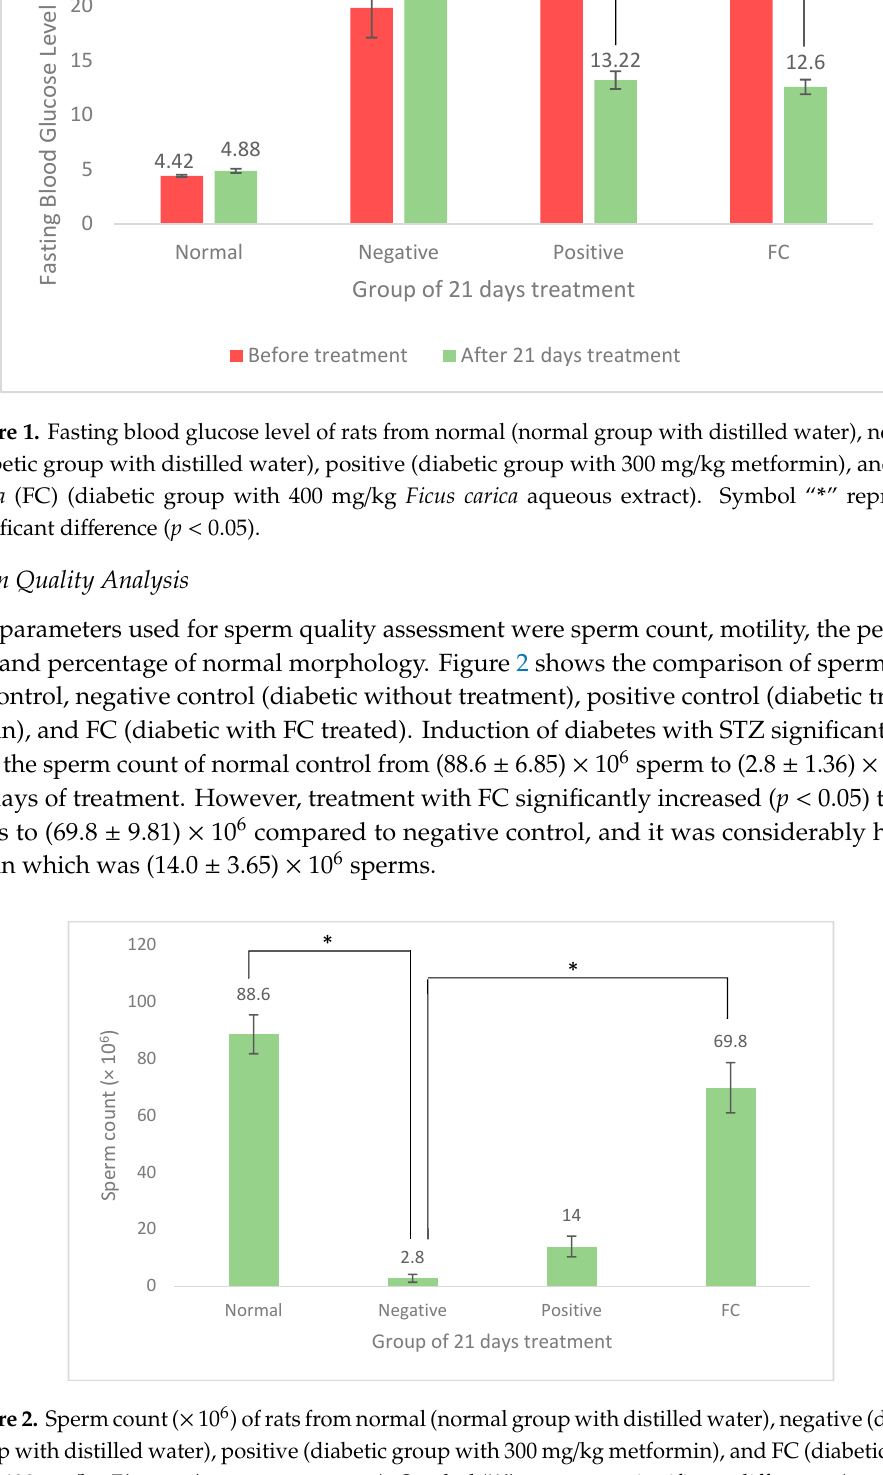
Figure 3. Sperm motility (%) of rats from normal (normal group with distilled water), negative (diabetic group with distilled water), positive (diabetic group with 300 mg/kg metformin), and FC (diabetic group with 400 mg/kg Ficus carica aqueous extract). Symbol “ * ” represents significant difference ( p < 0.05).